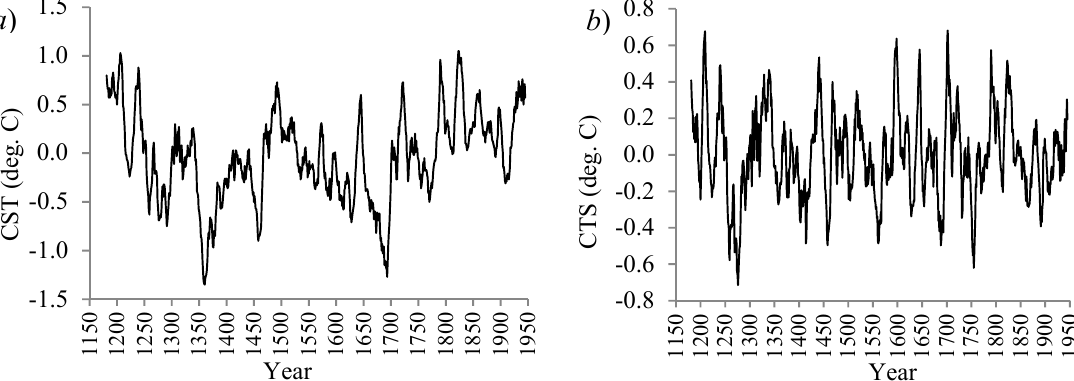
Figure 1. ( a ) The 765-years combined summer temperature (CST) record and ( b ) the deseasonalized and detrended CST time-series during the period 1181–1945, obtained from the sediments of the proglacial Lake Silvaplana (south-eastern Swiss Alps, coordinates: 46 ◦ 27’N, 9 ◦ 48’E, altitude: 1800 m).